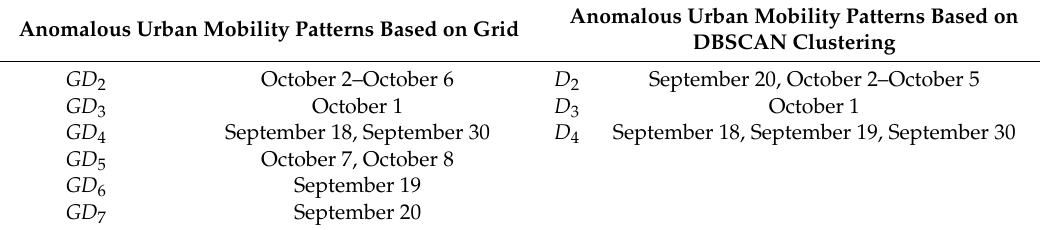
Table 6. Anomalous urban mobility patterns’ detection based on a grid.